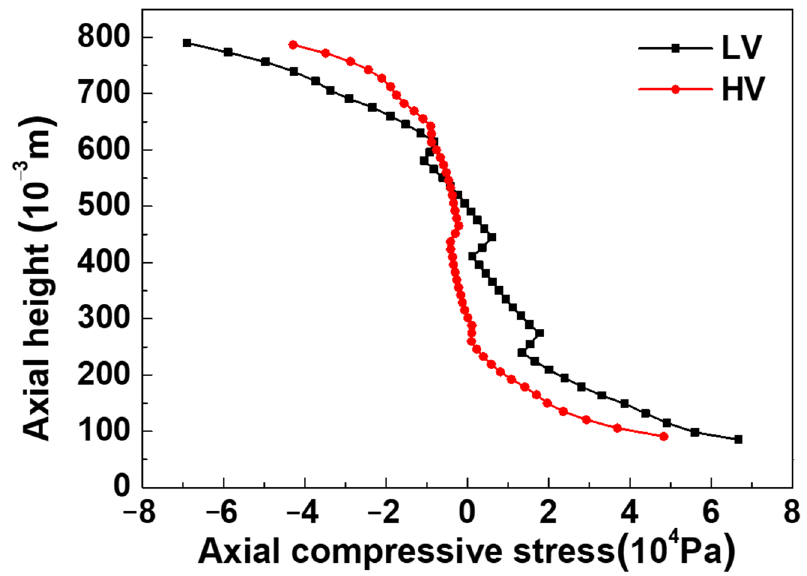
Figure 16. Distribution of axial compressive stress on the insulation spacers under steady-state operating conditions. Table 6. Axial compressive stress on the insulation spacers in the SZ-50000/110 transformer. Stress on Spacers